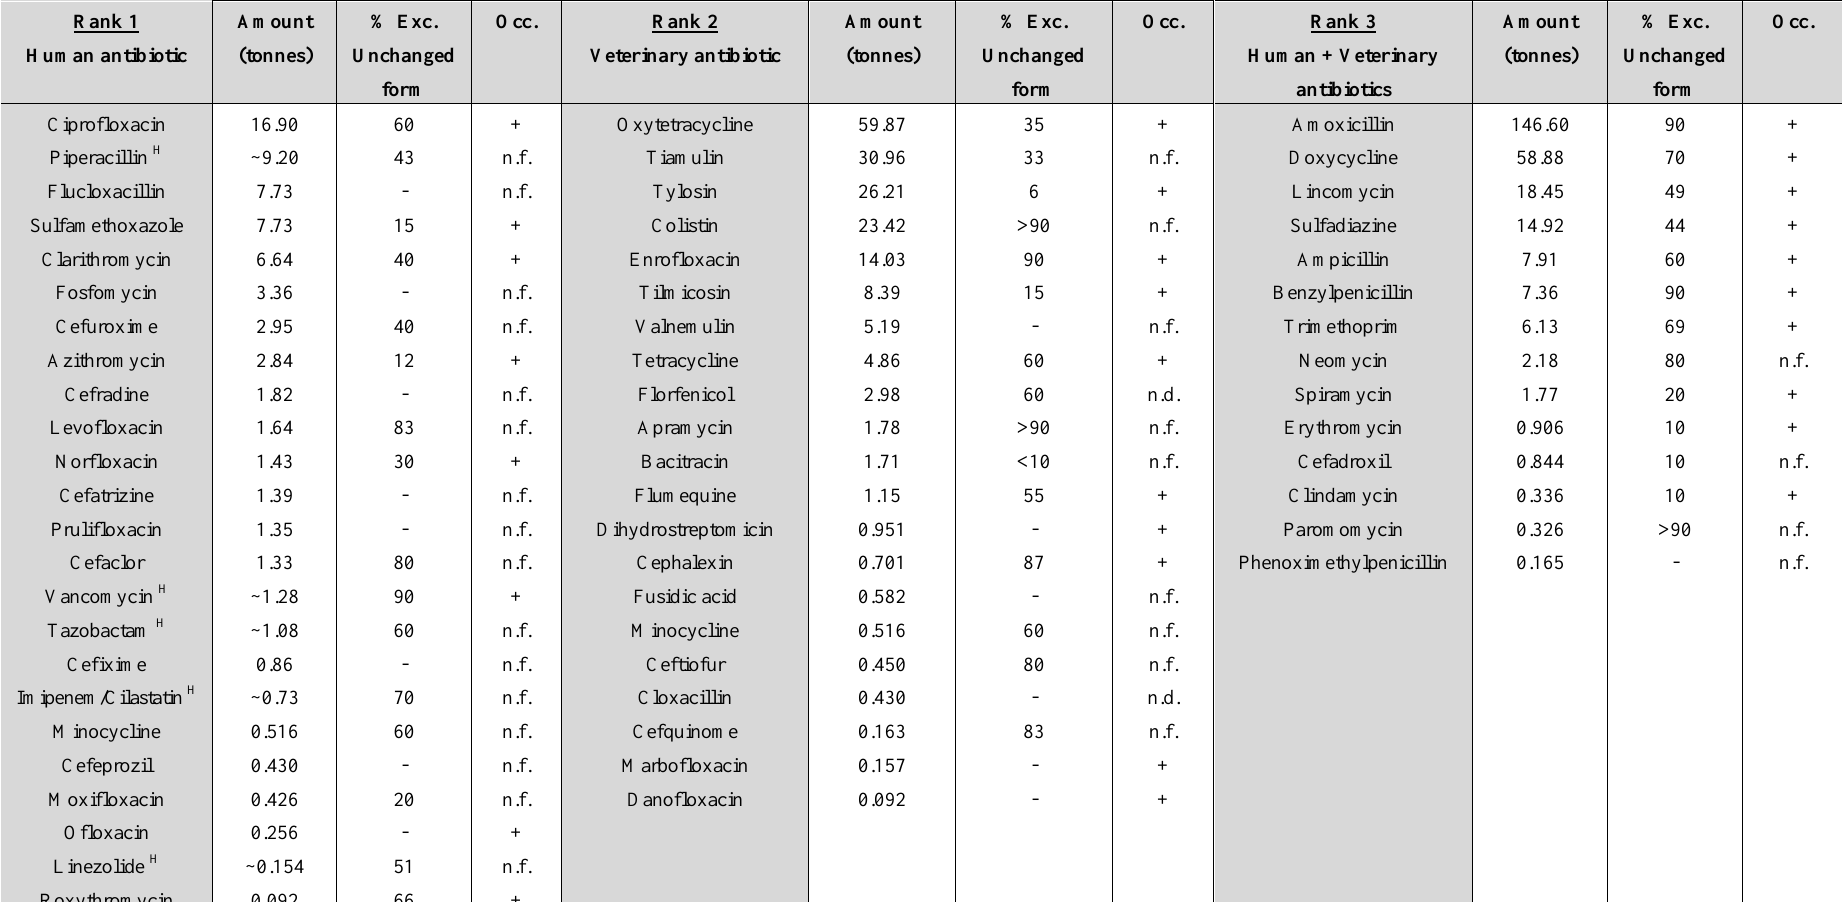
Table 4. Ranking of the most consumed antibiotics (above 0.090 tonnes), correlated with their parent compound excretion (%) and environmental occurrence (Occ.), used only in human medicine (Rank 1; including of exclusive hospital use, marked H ) and veterinary medicine only (Rank 2) and active substances authorized for both practices (Rank 3), in the two studied years. Rank 1 Amount % Exc. Occ. Rank 2 Amount % Exc. Occ. Rank 3 Amount % Exc. Human antibiotic (tonnes) Unchanged Veterinary antibiotic (tonnes) Unchanged Human + Veterinary (tonnes) Unchanged form form antibiotics + Oxytetracycline n.f. Tiamulin n.f. Tylosin Colistin Enrofloxacin Tilmicosin Valnemulin